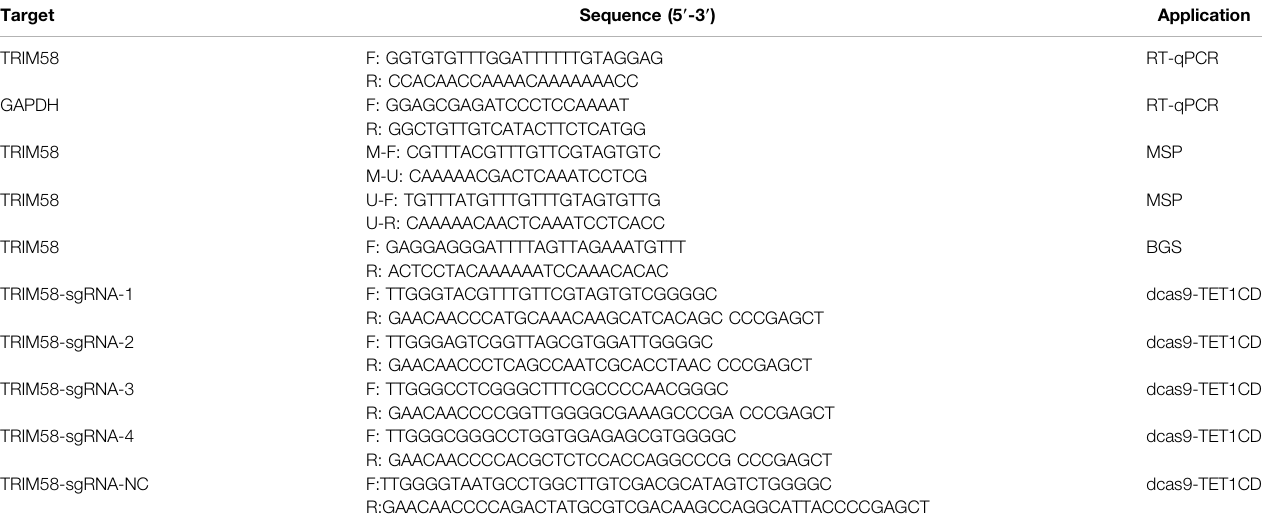
TABLE 2 | Primers for RT-qPCR, MSP, BGS and sequence of